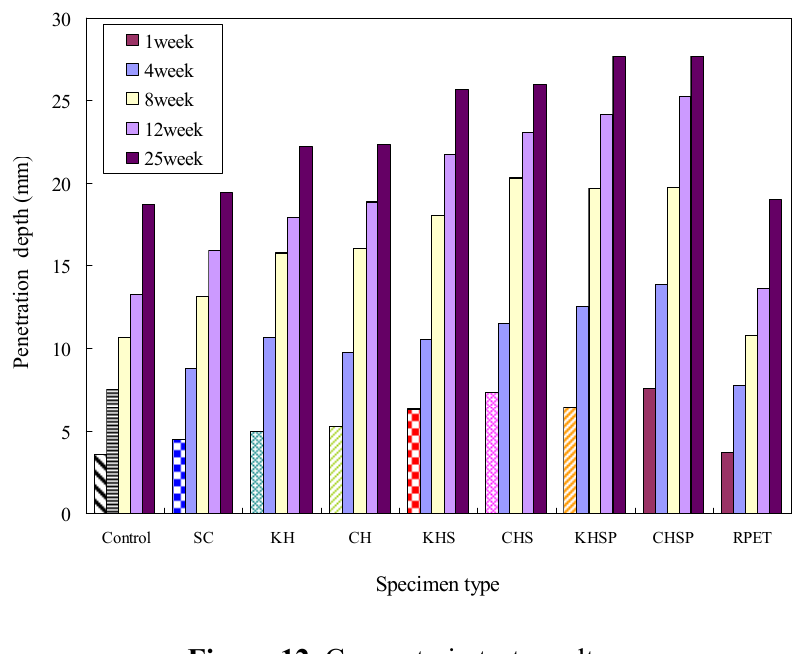
Figure 12. Creep strain test